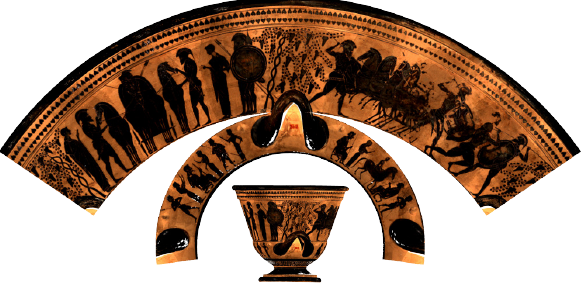
Figure 1: Unwrapping both figural friezes of a vessel (KHM Inv.- No. 3618 ) by fitting two different cones (Bechtold et al.,